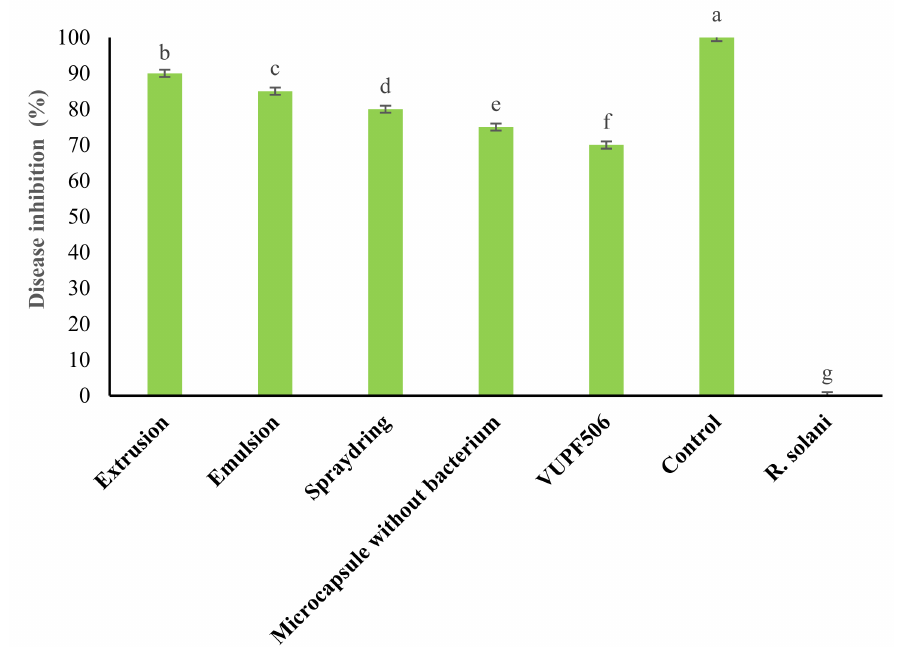
Figure 5. Effect of treatment of potato plants with ALG–WP–CNT microcapsules produced by extrusion, emulsification, and spray drying, and containing Pseudomonas chlororaphis VUPF506, on disease inhibition under greenhouse conditions. The experiment was arranged as a factorial in the framework of a completely randomized design with three replications. Error bars represent standard error, and letters indicate a statistical difference compared to the control ( p < 0.05). Means with the similar letters in the same columns are not significantly different at 5% of probability level based on Duncan Multiple Rang Test.